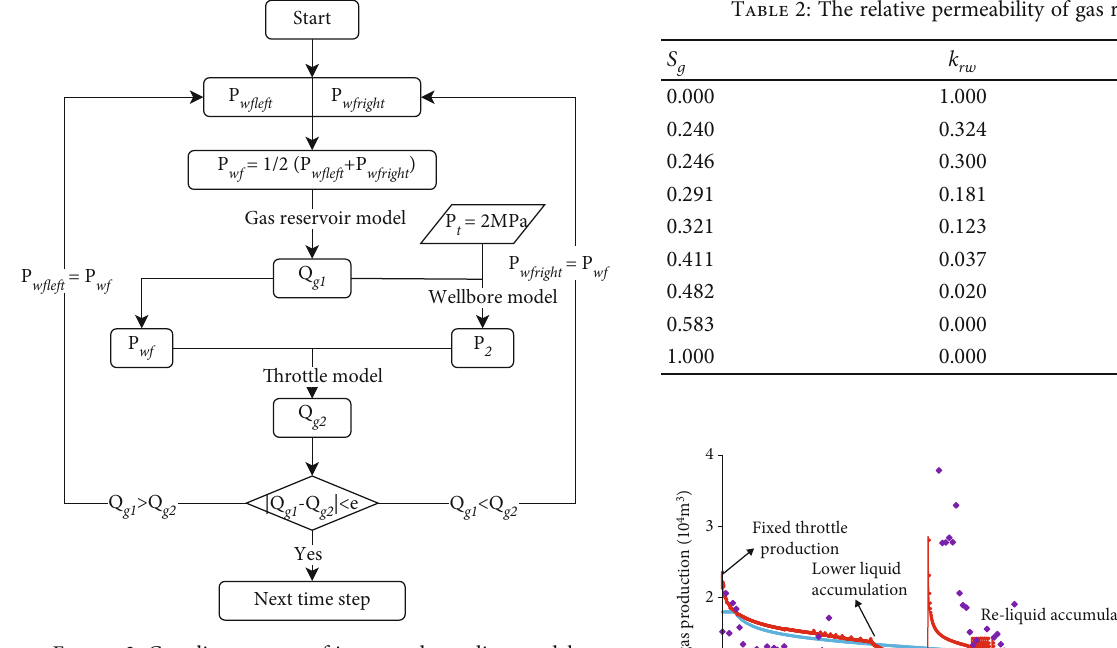
Figure 3: Coupling process of integrated coupling model.